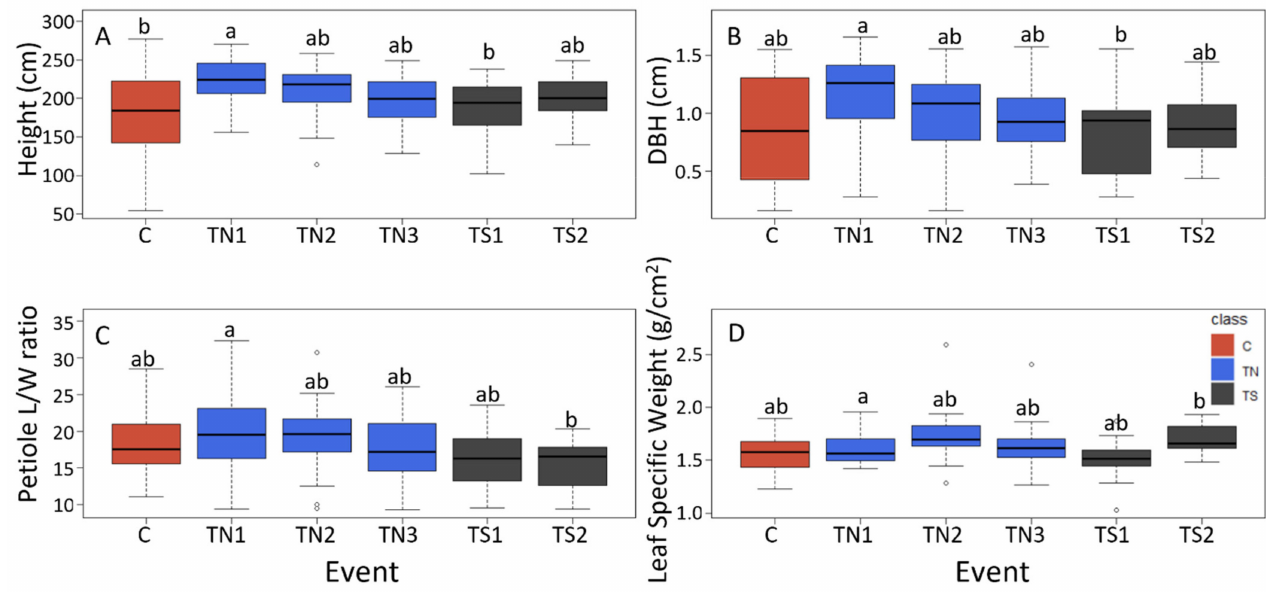
Figure 4. Representative traits with statistically significant variation among events or groups based on ANOVA for 2019. These included ( A ) height, ( B ) DBH, ( C ) petiole length to width ratio, and ( D ) leaf-specific weight. To remove block effects when visualizing event-based variation, boxplots were calculated based on deviations from block means for individual trees (with overall means added back to provided normalized trait values for each tree). Dark lines in bars show means of events, whiskers show extent of variation. Small letters indicate significant differences between events based on Tukey tests ( p <